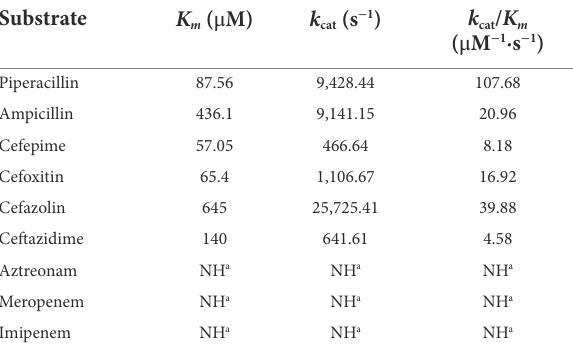
TABLE 4 Kinetic parameters of the β -lactamase LAQ-1 for β -lactam antimicrobials.